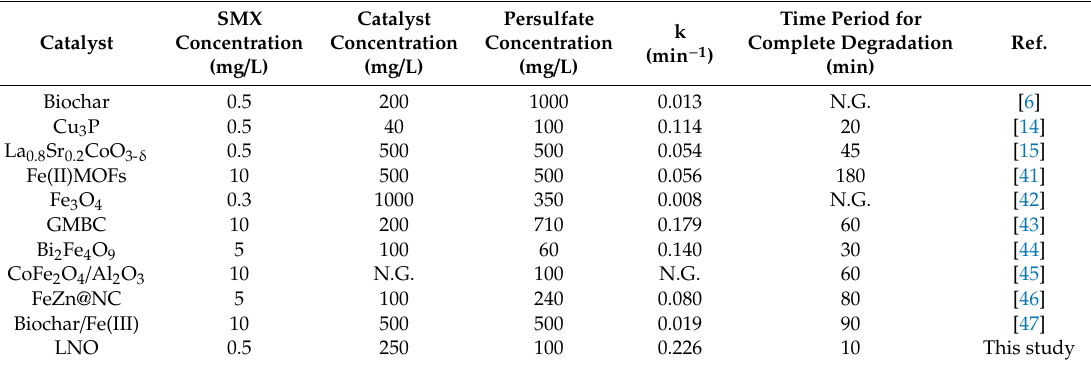
Table 1. SMX degradation in di ff erent heterogeneous activated persulfate systems. N.G.: not